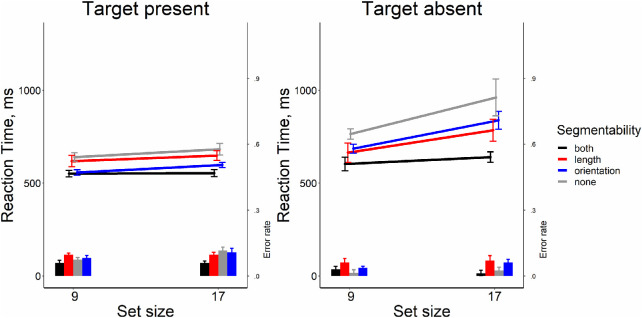
Reaction time and error rate as a function of set size and segmentability in Experiment 2. Error bars denote the SEM, with between-subject variance removed in accordance with the Cousineau (2005) method.